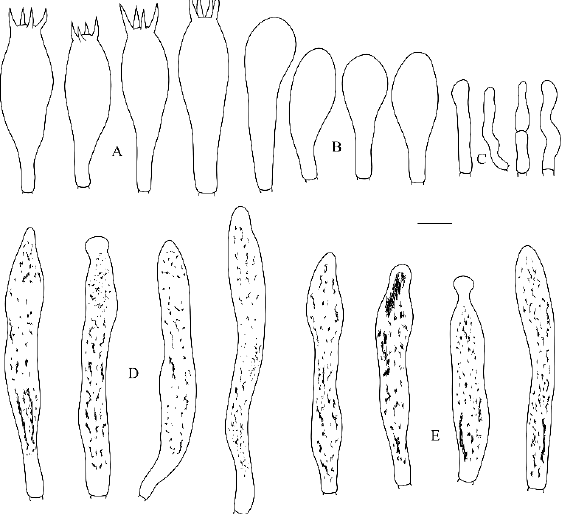
Figure 3. Russula subbrevipes (RITF3136). ( A ) Basidia. ( B ) Basidiola. ( C ) Marginal cells. ( D ) Hymenial cystidia on lamellae sides. ( E ) Hymenial cystidia on lamellae edges. Scale bar: ( A – E ) = 10 µ m.